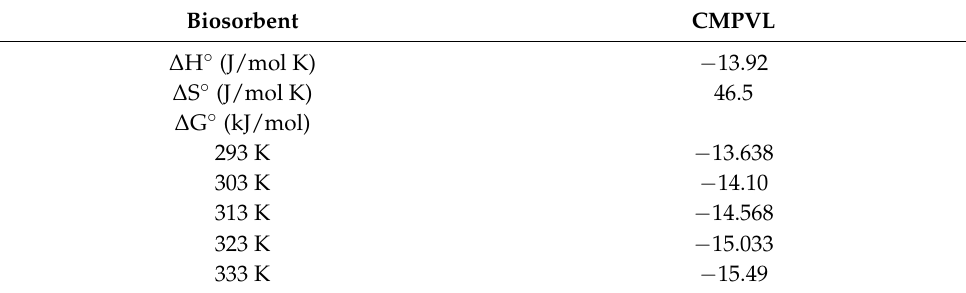
Table 4. Thermodynamic parameters for Fe(II) biosorption on CMPVL.